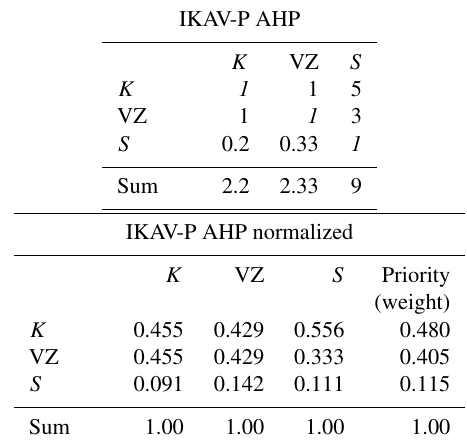
Table 2. Analytical hierarchy process (AHP) and eigenvalues for the selected map layers.